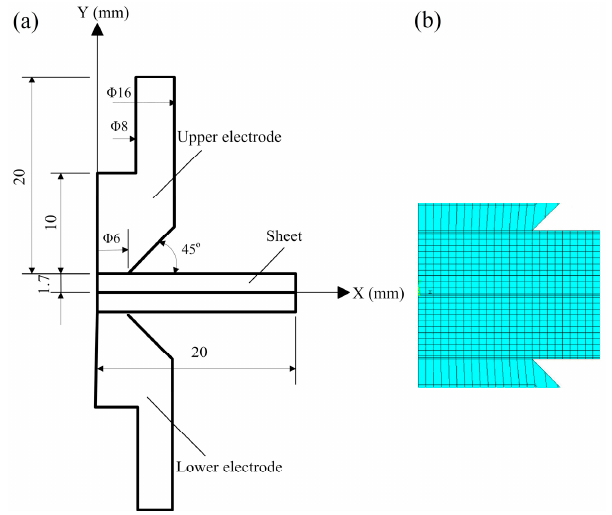
Figure 1. Finite element model employed to simulate RSW process: ( a ) overall view; and ( b ) enlarged view. The solid element Plane42 was selected in the squeeze stage. The contact surfaces between the electrode/workpiece and workpiece/workpiece with the action of the electrode force were flexible contacts, and the deformation and movement of the material were tracked by the elements TARGE169/CONTA172. The thermoelectric element Plane67 was selected for the electrical-thermal coupled analysis. The contact resistance is represented by a physical unit attached onto the surfaces of workpieces and electrodes by artificially adding a layer of 1/20 of the workpiece thickness. The structural element Plane42 was selected in the thermal analysis stage. As the same in the squeeze phase, the elements TARGE169/CONTA172 were employed to monitor the deformation and movement of the contact surface. The cooling water temperature inside the electrodes was assumed to be 10 ◦ C and the ambient temperature was 20 ◦ C. As the temperature was above 1500 ◦ C, DP600 sheet began to melt and this critical value was thought to be the threshold temperature for nugget formation. The surfaces of the electrode and thin sheets pass heat to the air by convection. The convective heat transfer coefficient for the cool water in the electrodes is 4.187 × 10 4 W/m 2 · K. The surface heat dissipation coefficients for electrode and metal sheets are presented in Figure